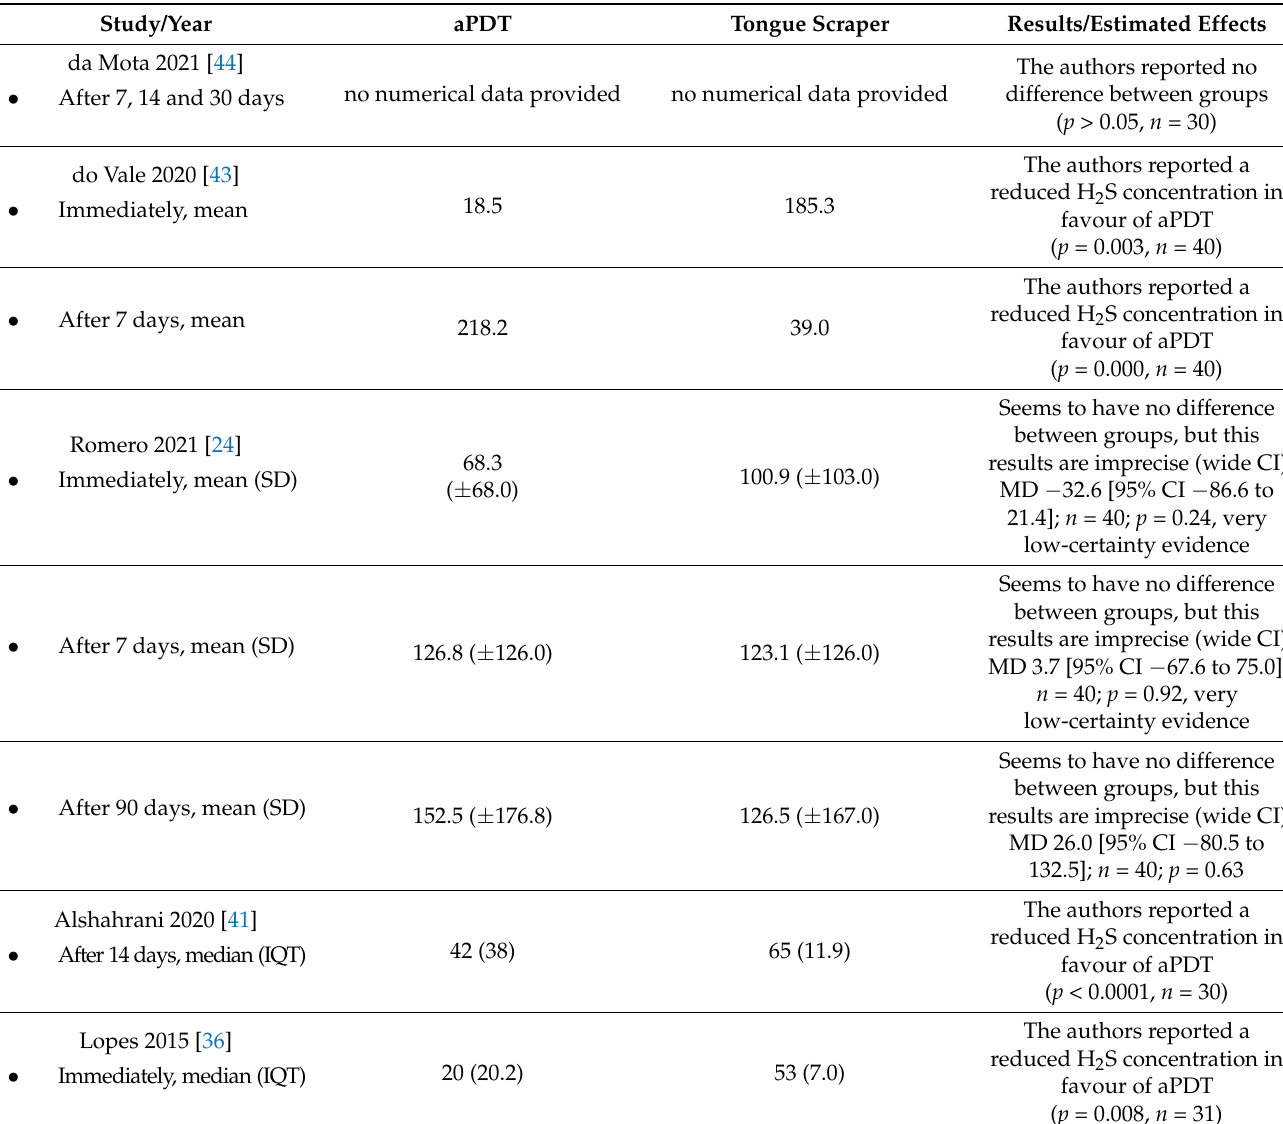
Table 2. Main results of the included studies on the reduction in Hydrogen Sulfide (H 2 S) gas concentration measured in ppb (parts per